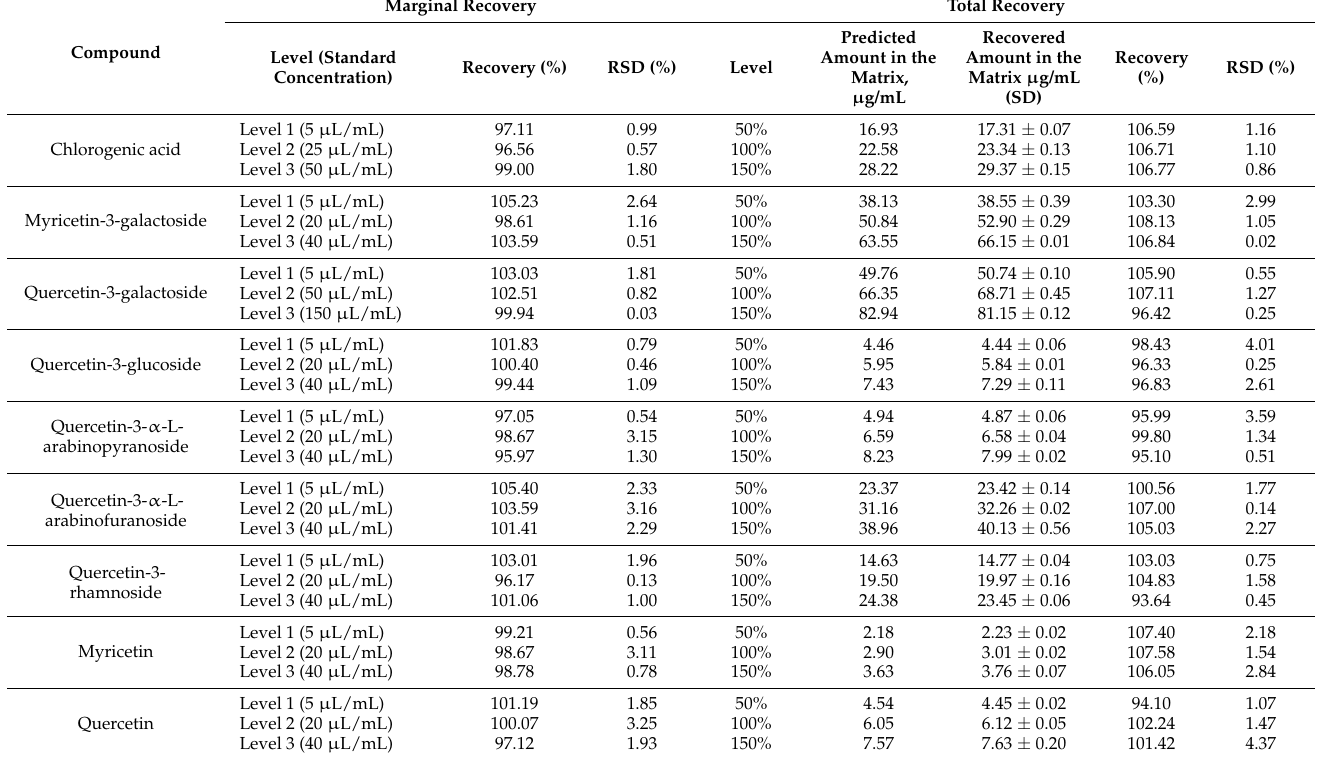
Table 3. Determination of the recovery in reference standards and the American cranberry